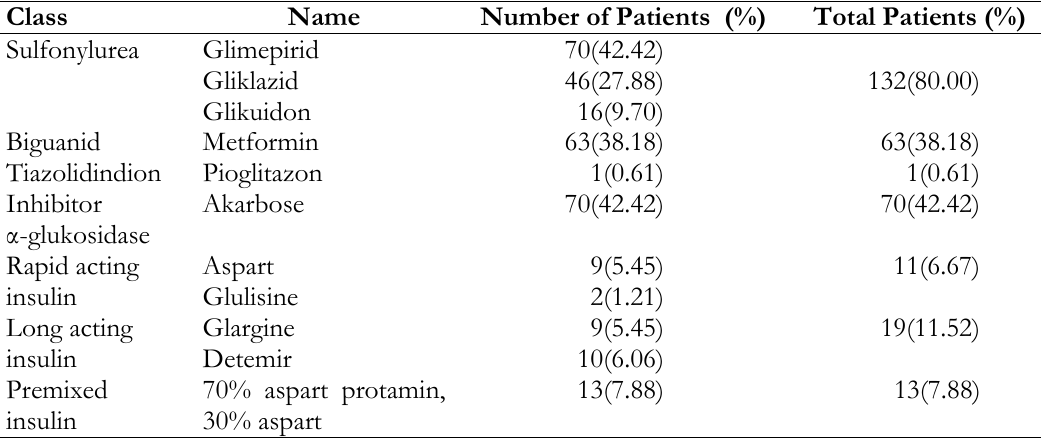
Table II Types of antidiabetic used in geriatric outpatients Dr. Soetomo Hospital Class